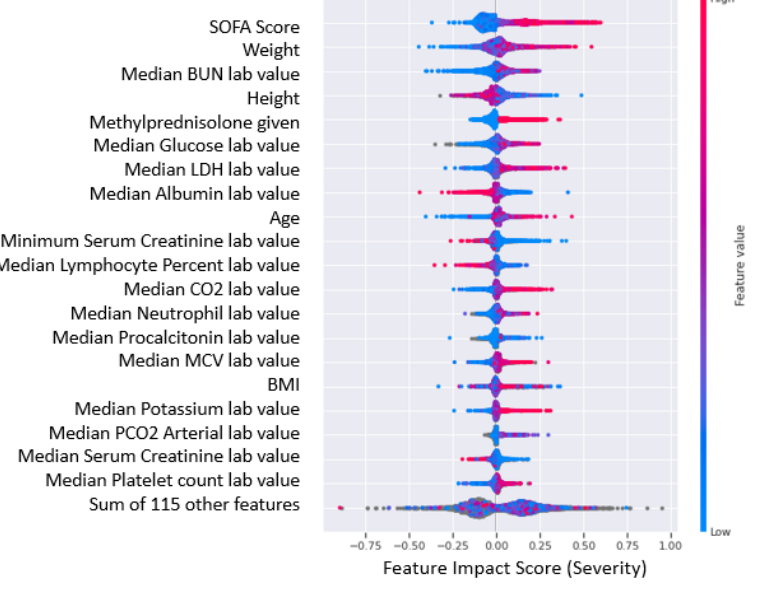
Figure 6. Top 20 most impactful features for COVID-19 severity predictive model. The red data points indicate higher values for the particular feature, while blue data points indicate lower values for the particular feature. A higher feature impact score indicates a higher contribution to a “severe” case prediction, while a lower feature impact score indicates a higher contribution to a “moderate” case prediction value.